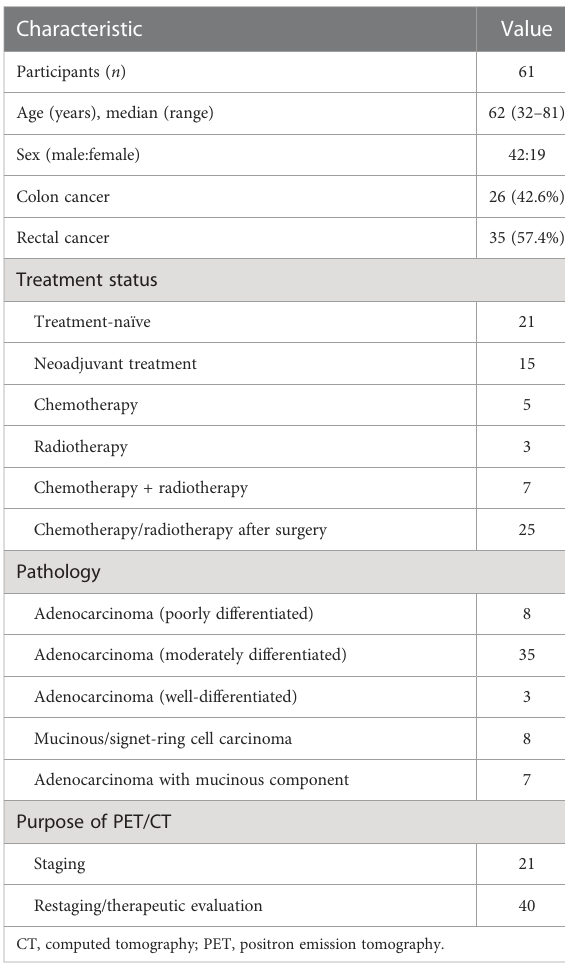
TABLE 1 Participants ’ characteristics.